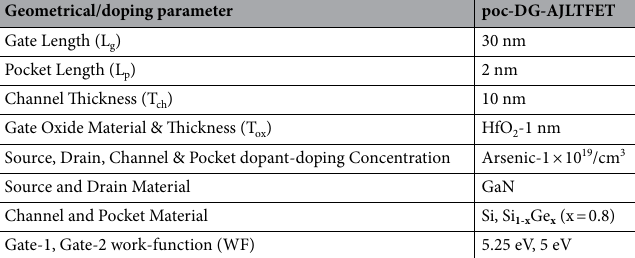
Table 1. Parameter Spacing of the